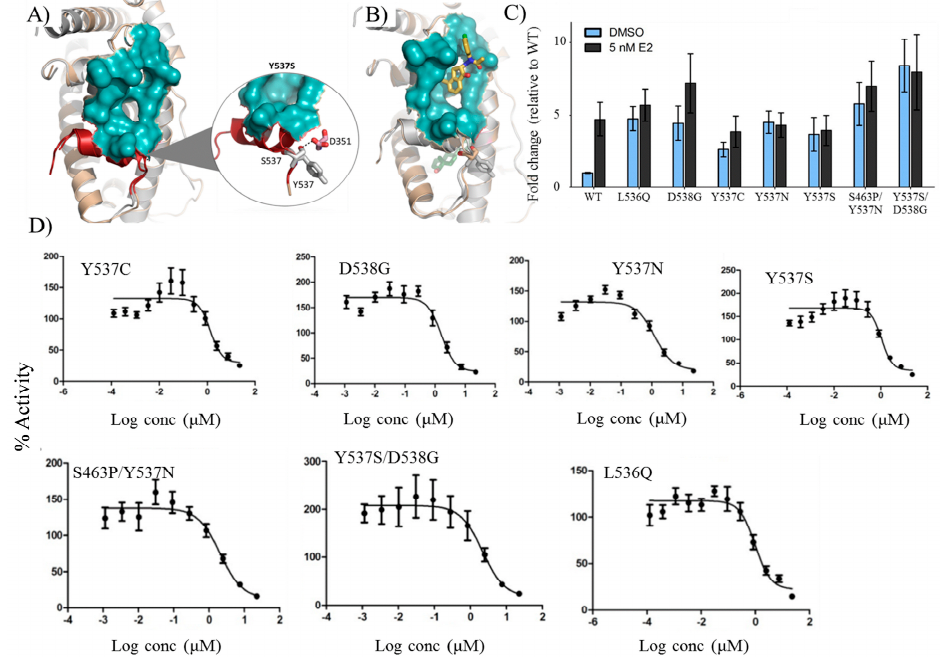
Figure 5. Predicted MD simulations and experimental effect of VPC-16606 on mutant forms of ER α . ( A ) Overlapping MD simulated structures of wild-type (WT) (grey) and Y537S (beige) forms of ER α show that an additional hydrogen bond formed between S537 and D351 in the mutant ER α (shown in a circle) causes the AF2 pocket (cyan) to be constitutively open. ( B ) Binding pose of VPC-16606 (yellow) in WT and mutant forms overlapped with each other shows that the compound would bind in a similar manner in both forms of ER α . ( C ) E2 responsiveness of the synthesized mutants. ( D ) pcDNA3.1 plasmid encoding either the full-length WT or mutant forms of ER α was transfected into MDA-MB-231 cells along with the 3X-ERE-TATA luciferase reporter plasmid. The cells were treated with a two-fold dilution of VPC-16606 starting at 50 µ M. The compound successfully inhibited the constitutively-active mutant forms of the receptor in a dose-dependent manner. Data points are expressed as the percentage of luciferase activity relative to DMSO control. Data were fitted using the log 10 of concentration of the inhibitors vs. the response with GraphPad Prism 6. Error bars indicate the standard error of the mean (SEM) for 3 independent experiments performed in